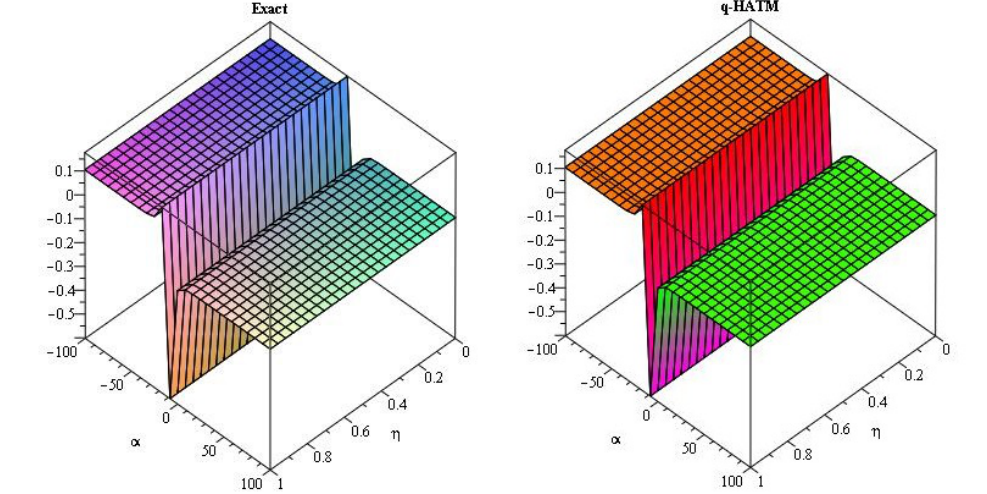
Figure 10. Exact and q-HATM solution of µ ( α , η ) at δ = 1.